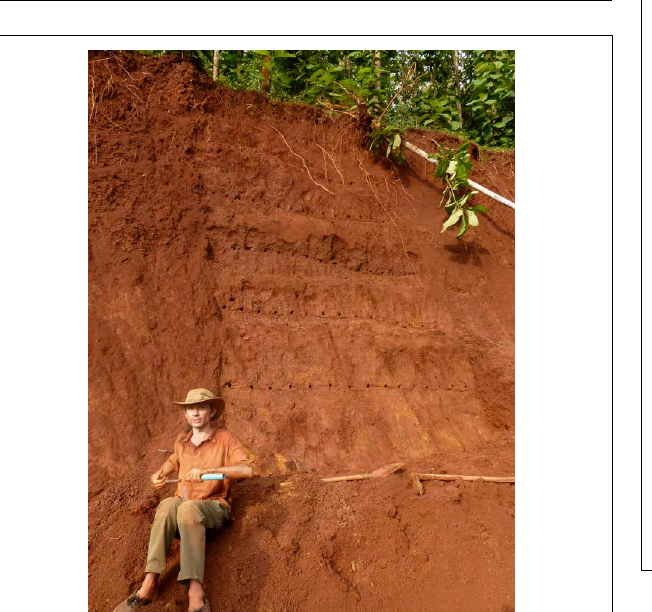
FIGURE 4 | Root sampling from an excavation (7m deep) in Lao PDR (Maeght, 2009).